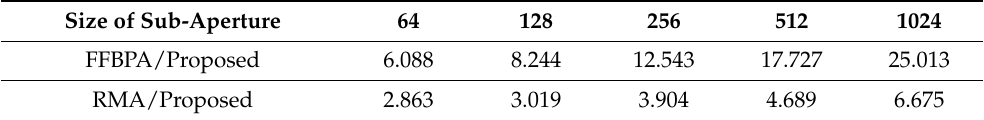
Table 4. Computational load